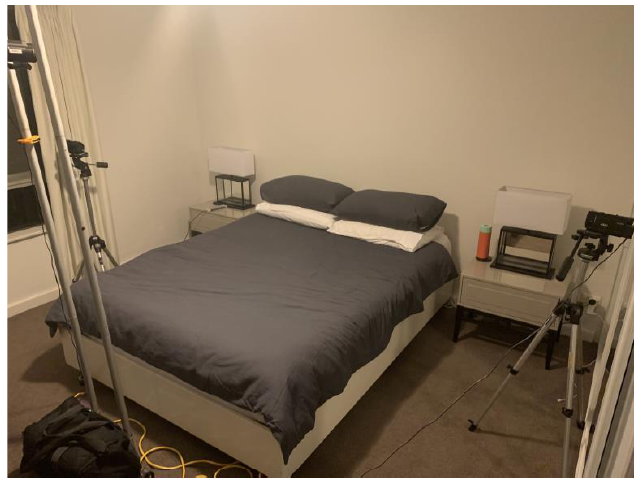
Figure 3. Camera Arrangement for Overnight